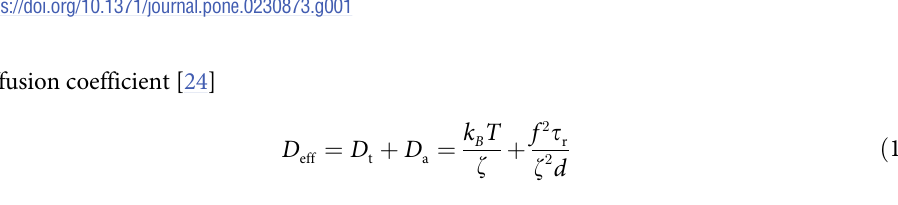
Fig 1. System setup. Left: The system consists of a food source that emits food particles (green), surrounded by BPs (black) and ABPs (red). Right: If an ABP runs into a food particle, it temporarily turns active and exhibits a persistent motion. The BP consumes food, too, but remains a passive Brownian walker. Which strategy is superior?